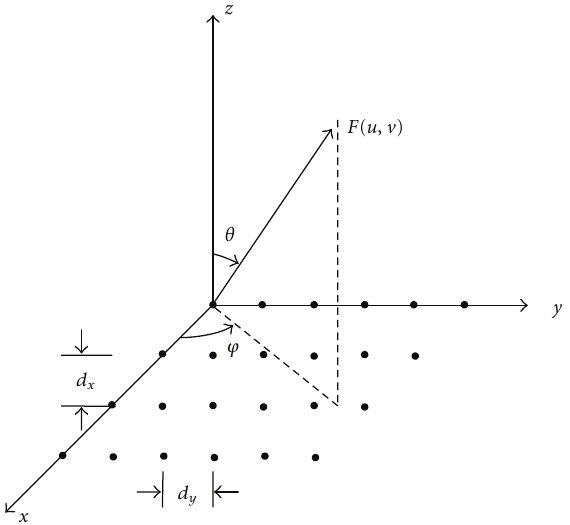
Figure 1: Geometry of M × N -element planar array on the x - y plane.